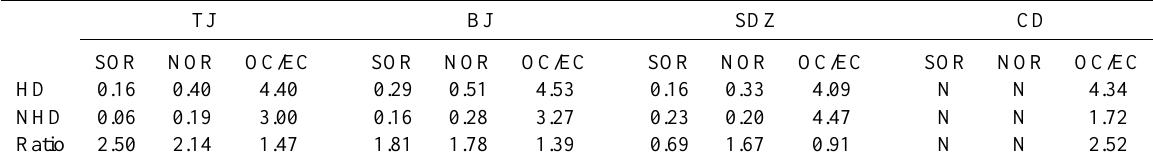
Table 1. SOR, NOR and OC/EC during haze days and non-haze days at four sites.